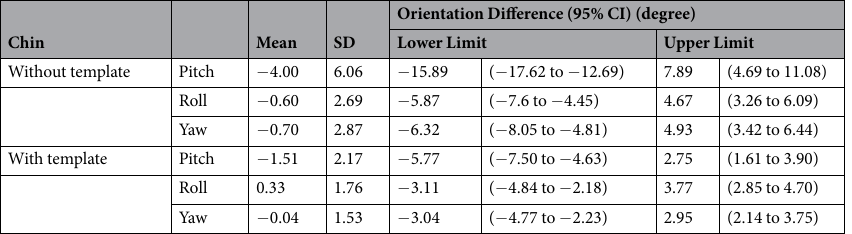
Table 3. Bland-Altman’s Accuracy Estimate of Orientational Differences between the Planned and Postoperative Outcomes